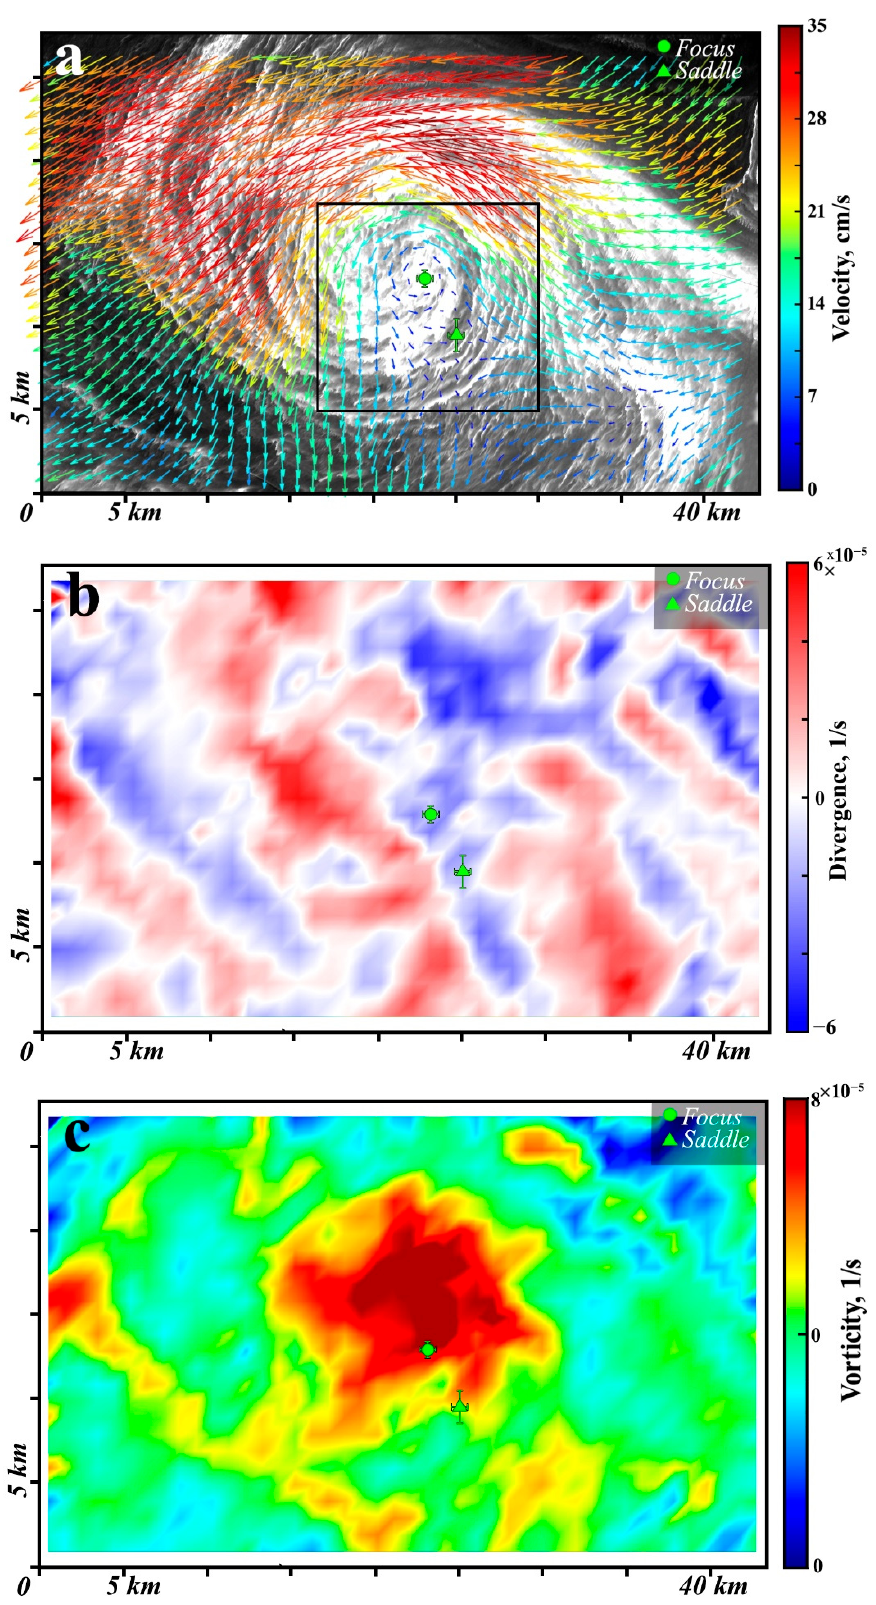
Figure 4. Horizontal velocity field obtained using the MCC method ( a ), map of divergence ( b ) and vorticity ( c ), all for green band. The images depict the positions of zero-velocity points, see the legend.